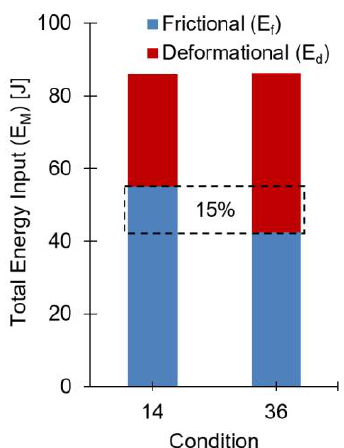
Figure 6. Energy input comparison between Conditions 14 and 36 with total energy input of 86 J.